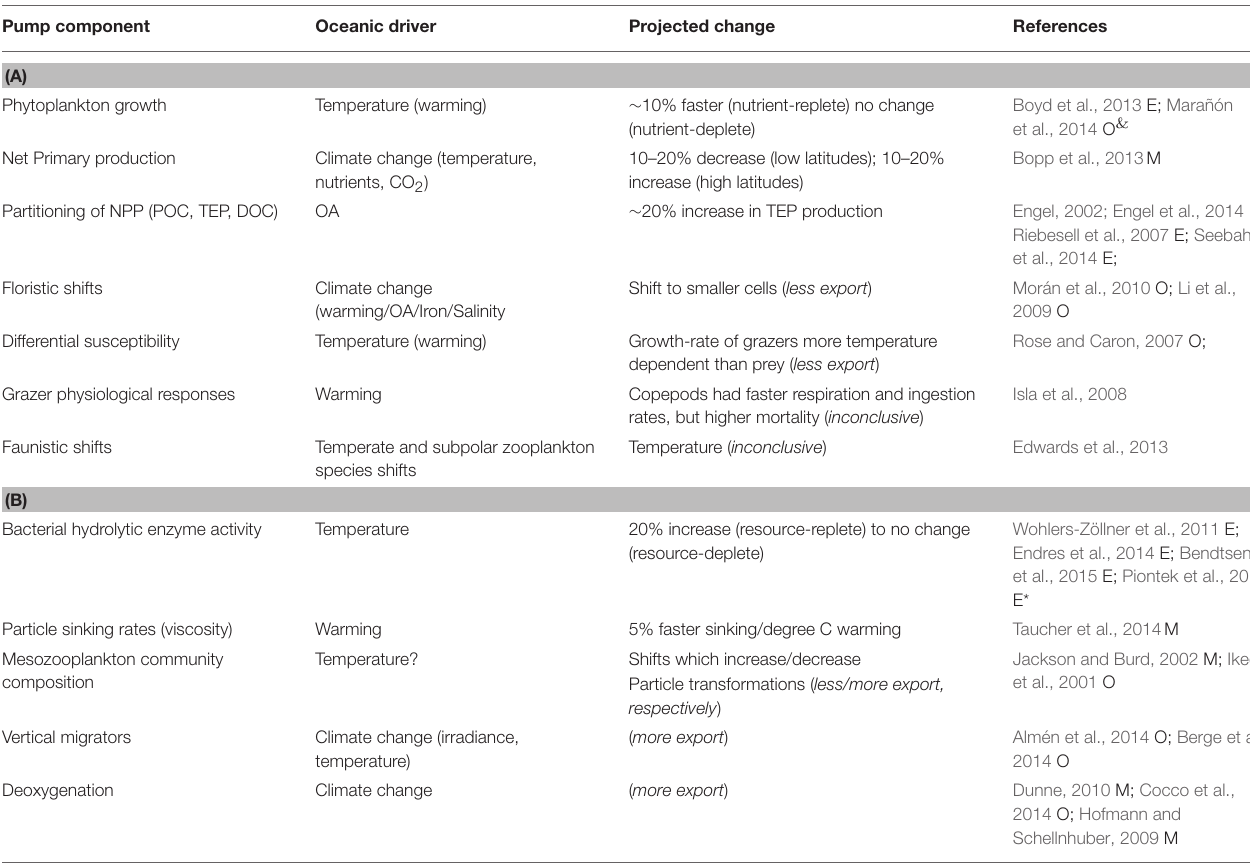
TABLE 3 | Summary of projected climate-change mediated alteration of components of the biological pump for (A) surface and (B) subsurface